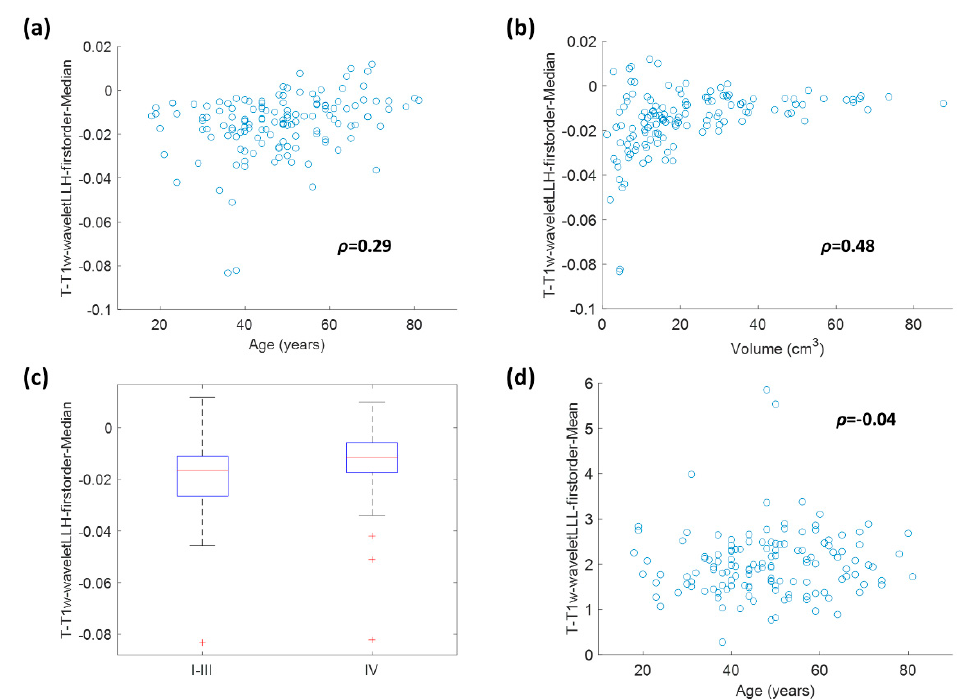
Figure 5. Boxplots and scatterplots representing the association of T-T1w-waveletLLH-firstorder- Median with age ( a ), tumor volume ( b ) and overall stage ( c ), and the association of T-T1w- waveletLLL-firstorder-Mean with age ( d ). The Spearman correlation coefficients are reported on the scatterplots.